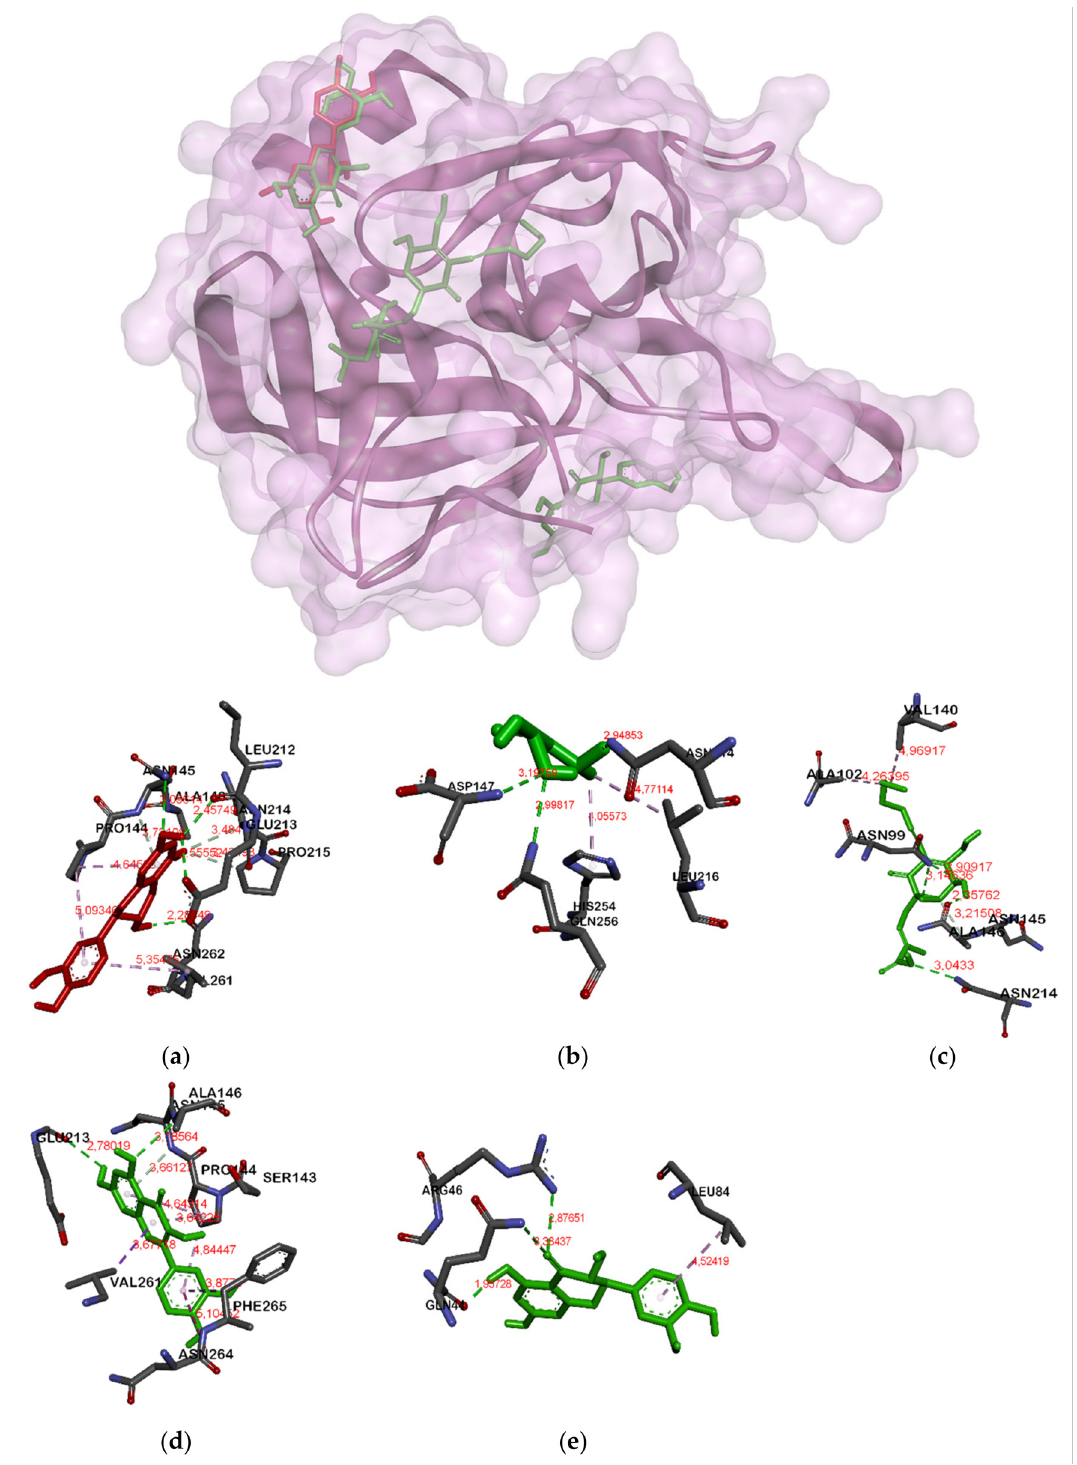
Figure 4. Binding site on serine protease for catechin ( a ), fosfomycin ( b ), ambuic acid ( c ), quercetin ( d ) and taxifolin ( e